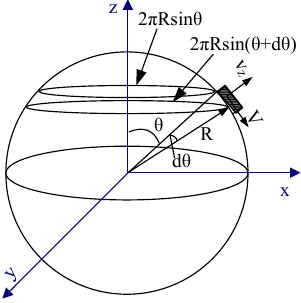
Figure 3. Annular control volume on spherical surface.